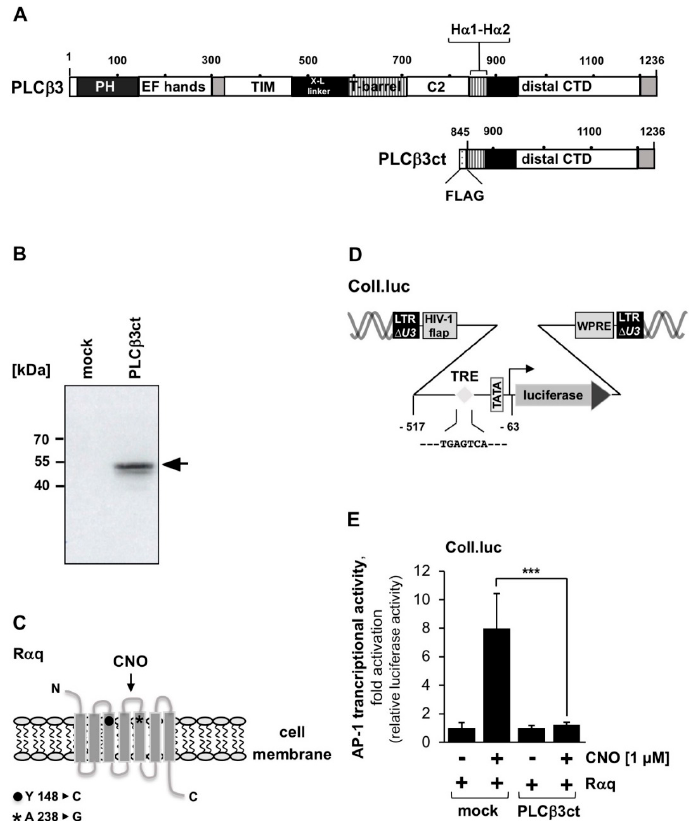
Figure 1. Expression of the C-terminal domain of phospholipase C β 3 blocks signaling of R α q, a G α q-coupled designer receptor. ( A ) Multi-domain structure of phospholipase C β 3 and the trun- cated mutant PLC β 3ct. PLC β 3 contains a pleckstrin homology (PH) domain, four tandem EF-hand repeats, the catalytic triose phosphate isomerase (TIM) barrel domain, the C2 domain, the helix- turn-helix motif (H α 1—H α 2), and a C-terminal domain (CTD). ( B ) Expression of PLC β 3ct mutant in HEK293 cells following infection of the cells with an PLC β 3ct-encoding lentivirus. Cells were infected with a lentivirus encoding either PLC β 3ct or β -galactosidase (mock). The Western blot was developed with an antibody against the FLAG-tag. kDa, molecular mass markers. ( C ) Modular structure of R α q. The two-point mutations essential to change the M3 muscarinic acetylcholine re- ceptor into a G α q-coupled, CNO-sensitive designer receptor, are indicated. ( D ) Provirus, depicting the Coll.luc reporter gene, used as a sensor to measure AP-1 activity. ( E ) HEK293 cells containing a chromatin-integrated Coll.luc reporter gene were infected with a lentivirus encoding the designer receptor R α q. In addition, cells were infected with a lentivirus encoding either PLC β 3ct or β -galac- tosidase (mock). Serum-starved cells were stimulated with CNO (1 μ M) for 24 h. Cell extracts were prepared, and luciferase activities and protein concentrations were determined. Luciferase activity was normalized to the protein concentration. Data shown are means +/ − SD of four experiments performed in quadruplicate (*** p < 0.001).